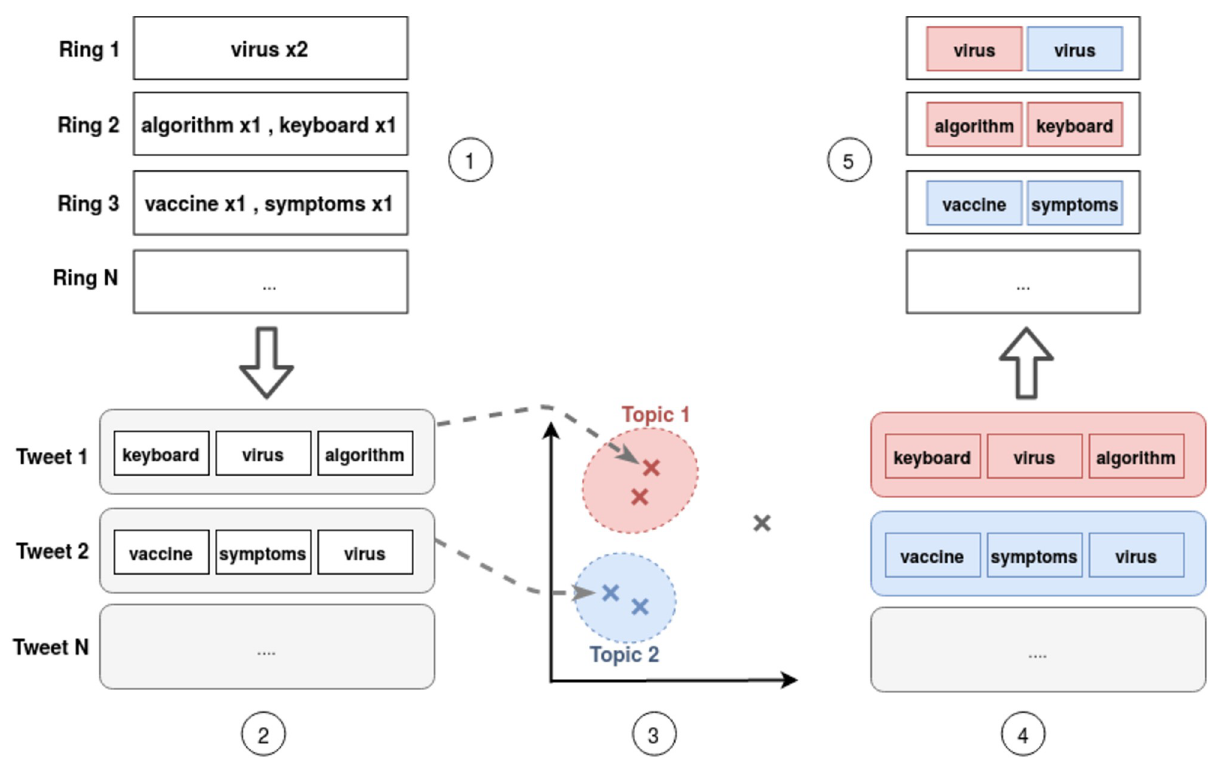
Fig 8. Obtaining the semantic profile of the rings of an ego network. (1) The ego network’s rings organize a user’s vocabulary based on the frequencies of the words. (2) For a given word, its occurrences in the user timeline are coming most likely from different tweets. (3) The tweets are classified by topic thanks to the BERTopic framework. (4) Each word occurrence is assigned the very same topic as the tweets it belongs to. (5) If we consider a ring as a multiset of words (with repetitions) the semantic profile is the distribution of the topics among those words.